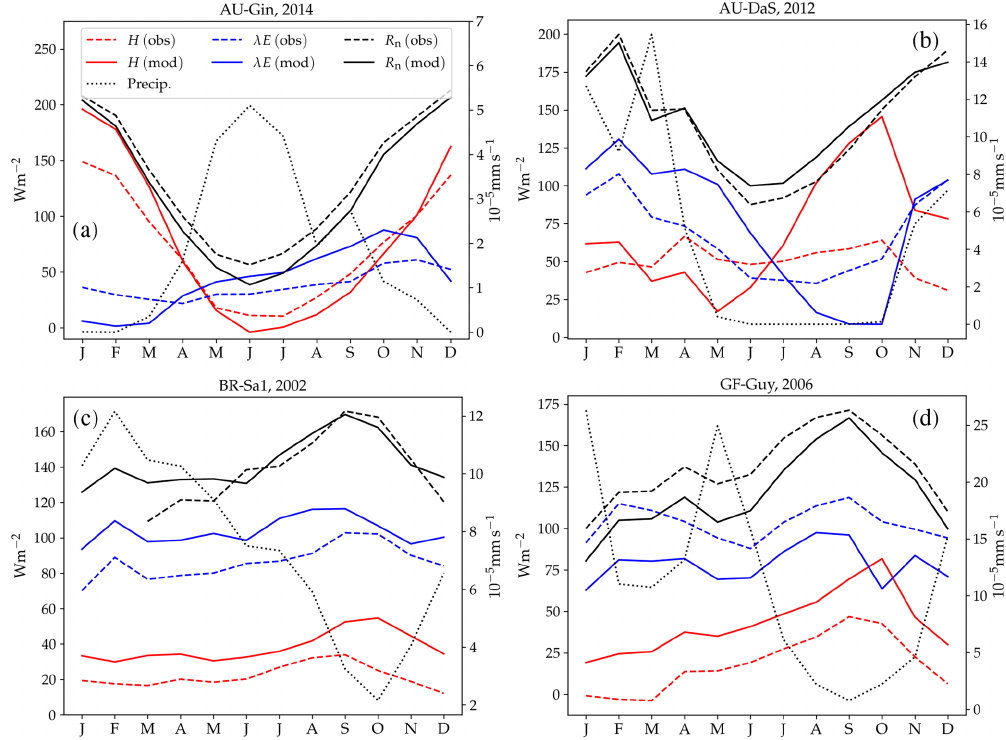
Figure 10. Observed and simulated annual cycles of sensible ( H ) and latent ( λE ) heat flux at four selected sites: Gingin ( AU-Gin, panel a) , Daly River Savanna ( AU-DaS, panel b) , Santarem-Km67 ( BR-Sa1, panel c) , and Guyana ( GF-Guy, panel d) . Mean monthly precipitation and observed and modelled net radiation ( R n ) are plotted for